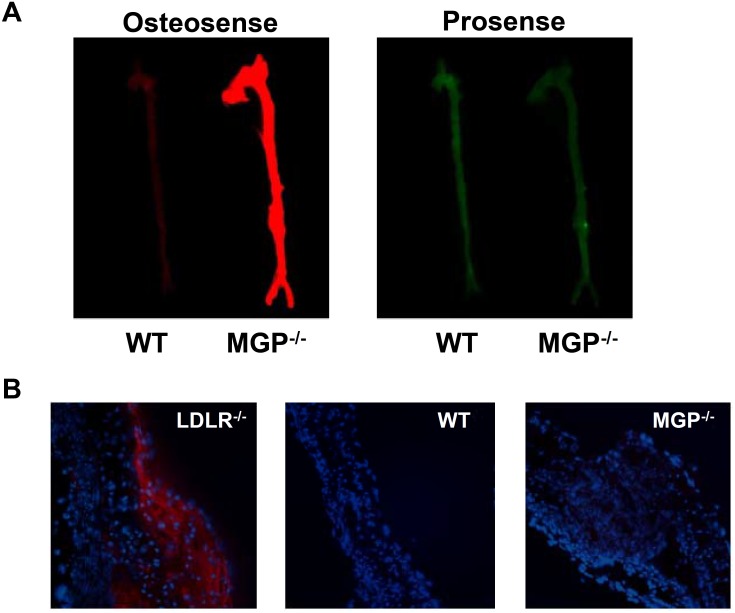
Vascular calcification associated with MGP deficiency occurs in the absence of vascular inflammation.(A) At 27 days of age, OsteoSense-680 and Prosense-750 were injected via the tail vein of wild-type (WT) and MGP-/- mice. Aortas were harvested 24 hours later and imaged. Although aortas from MGP-/- mice exhibited extensive vascular calcification, this calcification was not associated with increased macrophage activity. (B) Aortas were harvested from WT and MGP-/- mice at 28 days of age, sectioned, and stained for macrophages with an antibody directed towards MAC-2. Aortas from LDLR-/- mice on a high fat diet were used as a positive control. Nuclei were stained with DAPI. Similar to WT mice, macrophages were not detected by immunohistochemistry in the aortas of MGP-/- mice.